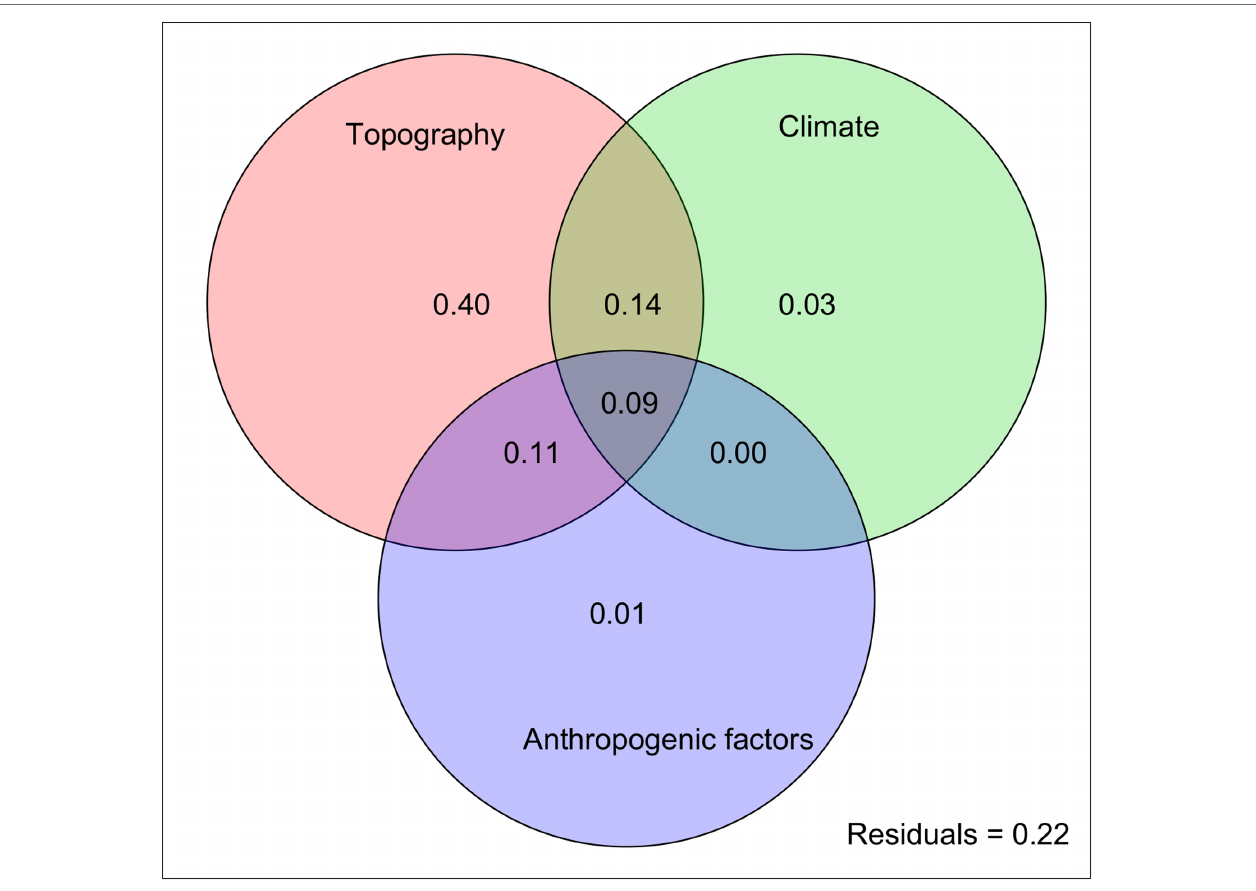
FIGURE 6 | RDA partitioning results showing the relative contributions of climatic, topographic, and anthropogenic factors (and their combinations) as predictors of genetic diversity in the Longitudinal Range Gorge Region